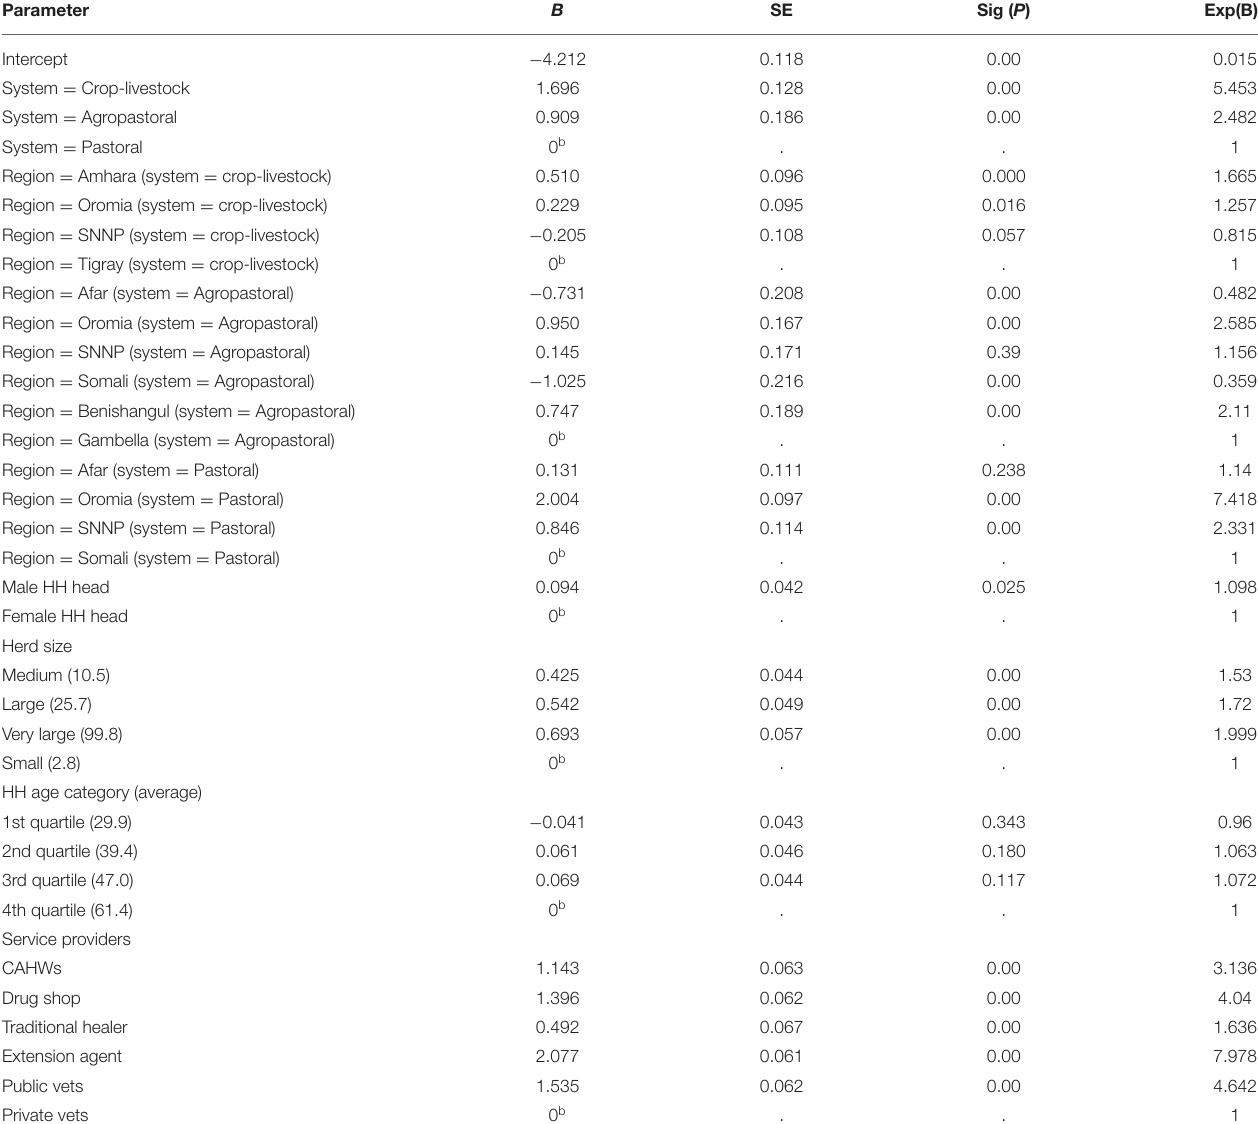
TABLE 4 | Biogeographic, socioeconomic, and institutional determinants of access to animal health services in Ethiopia.